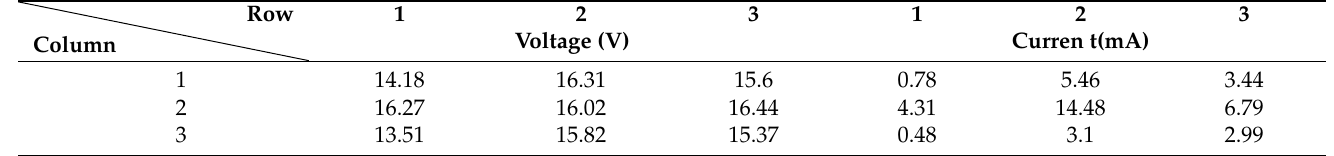
Table 5. The voltages and currents of the branch irradiated by the 808 nm laser.